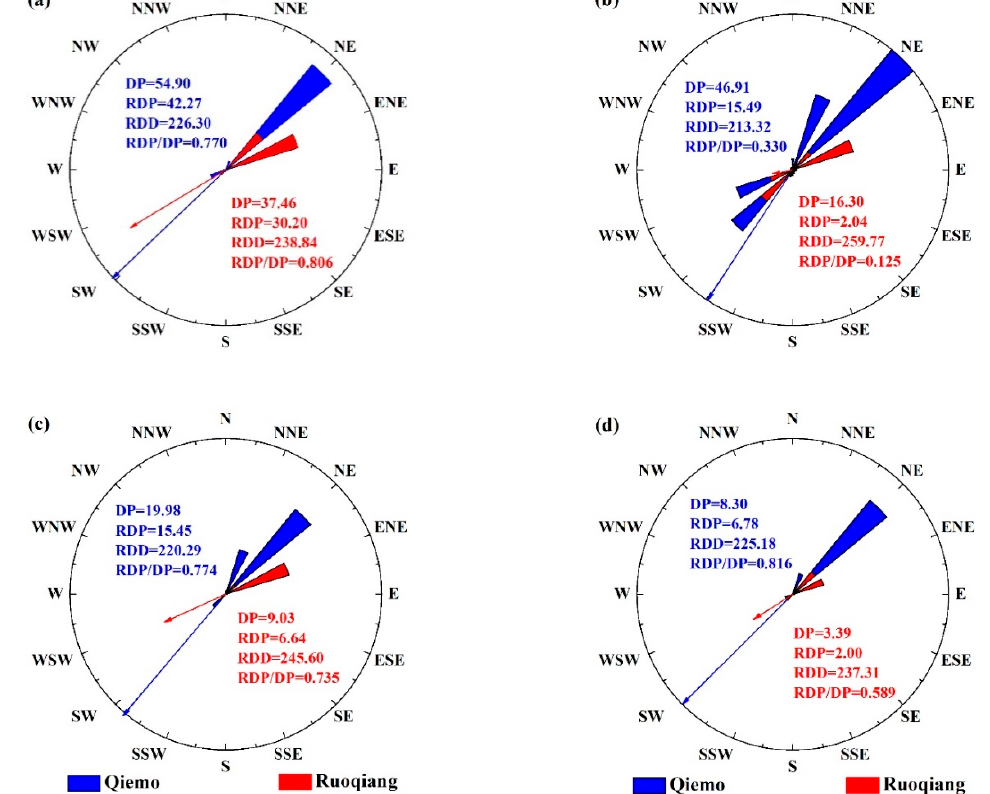
Figure 8. Characteristics of seasonal DP: ( a ) spring; ( b ) summer; ( c ) autumn; ( d ) winter.